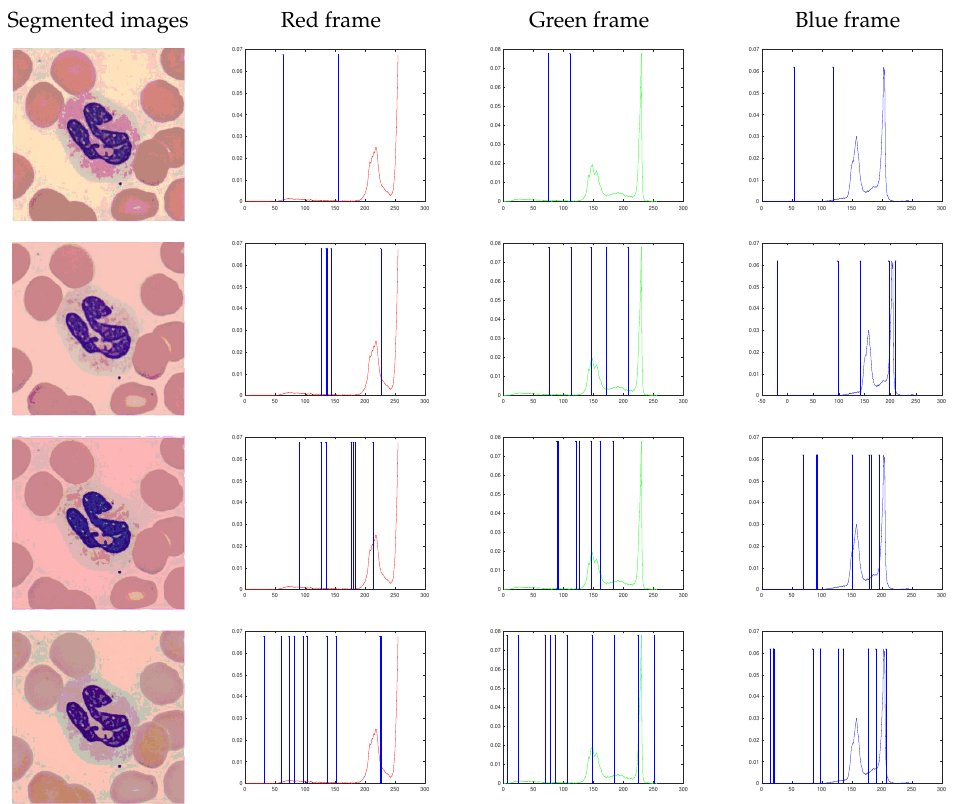
Figure 9. Threshold outcomes after executing mSAR on the Otsu method over the set of test